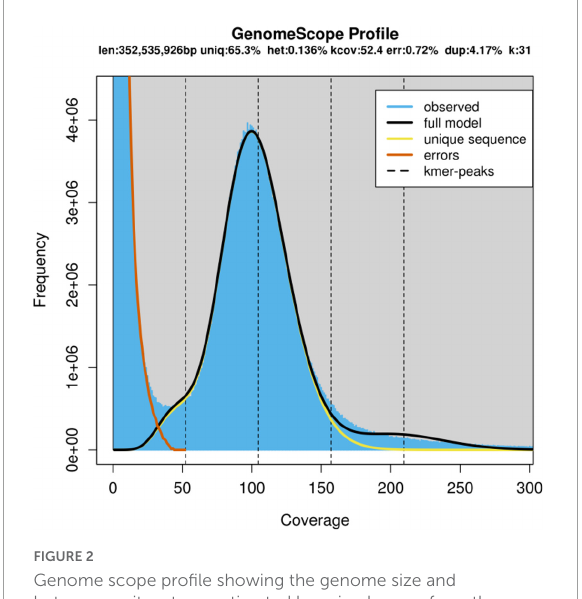
FIGURE2 Genome scope profile showing the genome size and heterozygosity rate as estimated by using k-mers from the ‘Bhagawa’